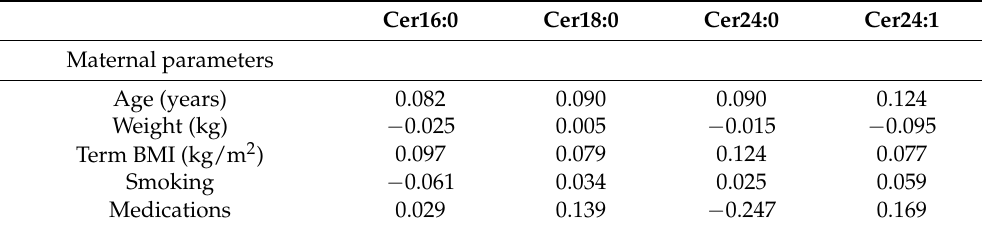
Table 3. Correlation among ceramide concentrations and studied parameters for all studied women (GDM and control groups).